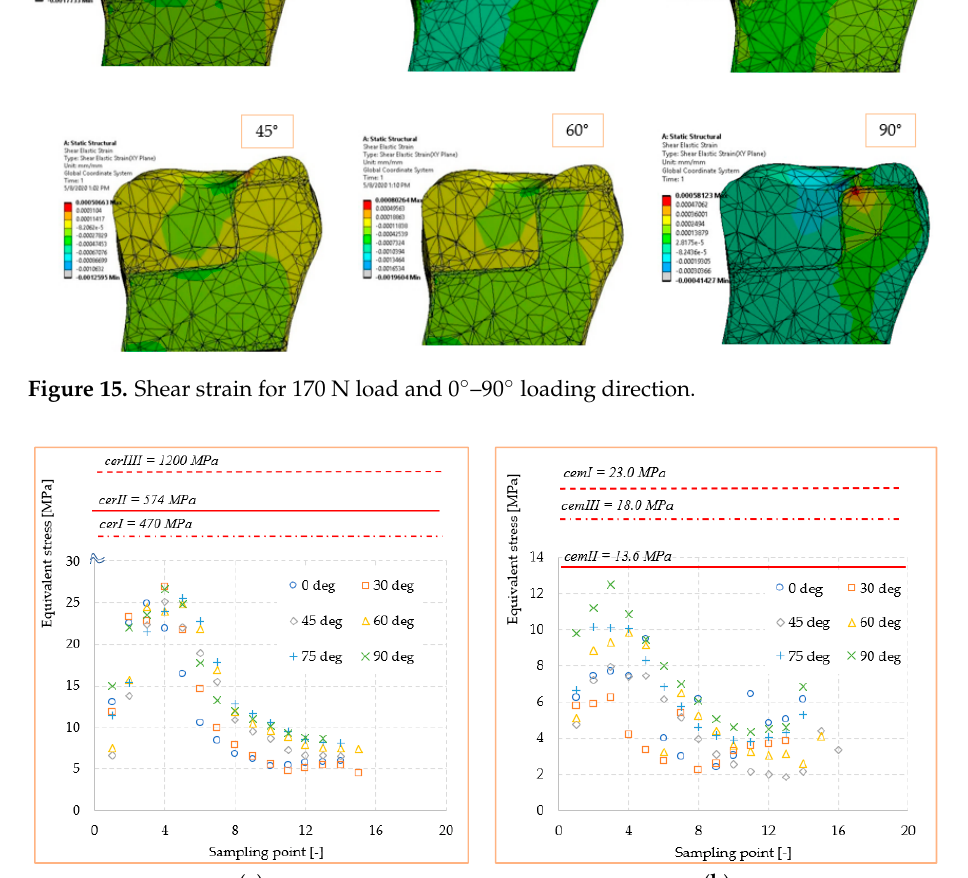
Figure 15. Shear strain for 170 N load and 0°–90° loading direction.